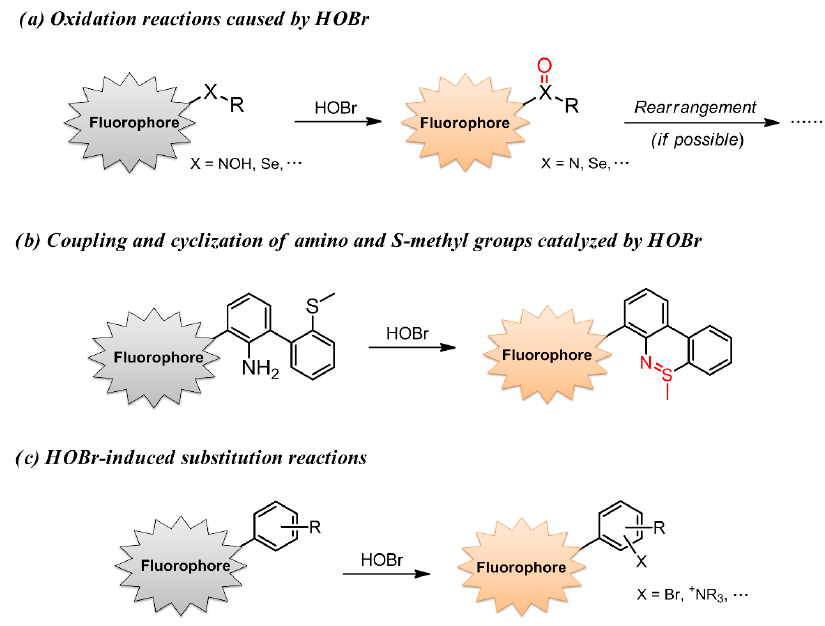
Figure 2. Three reported strategies to construct a suitable fluorescent probe for HOBr.